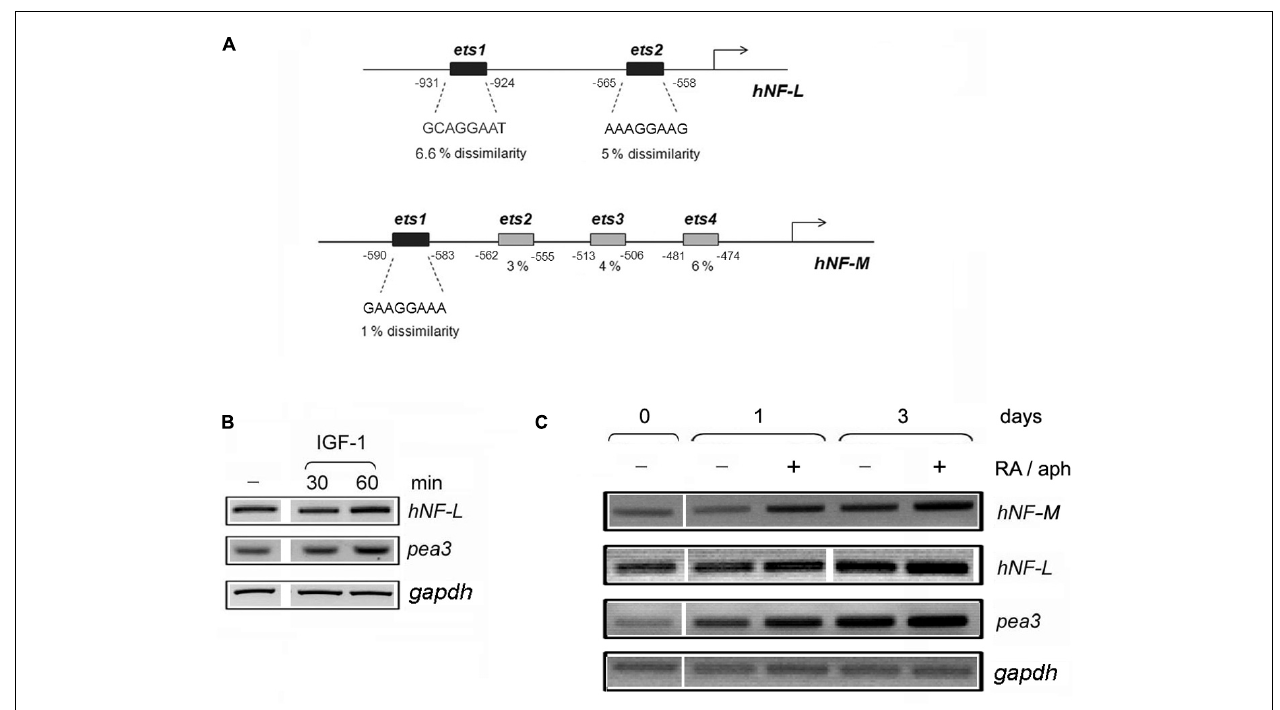
percentage with respect to the binding matrices) are written below the predicted ets motifs; (B) the expression analysis of NF-L and pea3 genes in SH-SY5Y cells stimulated with IGF-1 for 30 and 60 min; (C) the expression analysis of NF-M, NF-L, pea3 and gapdh genes in SH-SY5Y cells before (day 0) or after (days 1 and 3) of stimulation in the presence ( + ) or absence (-) of Retinoic acid and aphidicolin (RA/aph) as described in Sections “Materials and